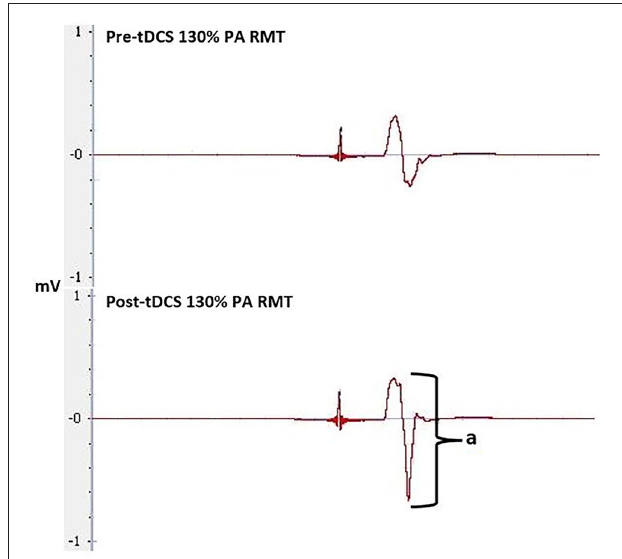
FIGURE 9 | Pre and post-tDCS MEPs elicited through 130% of RMT at the PA orientation. Amplitude (a) was used to compare MEP size pre- and post-tDCS to determine tDCS